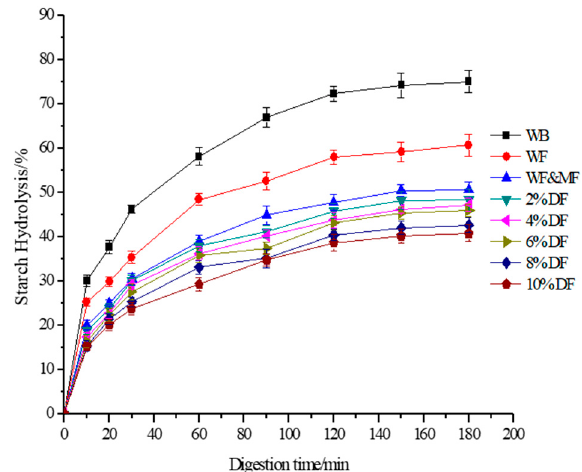
Figure 1. Effects of various samples on starch digestibility in vitro. WB represents the reference food (white bread) in this section.